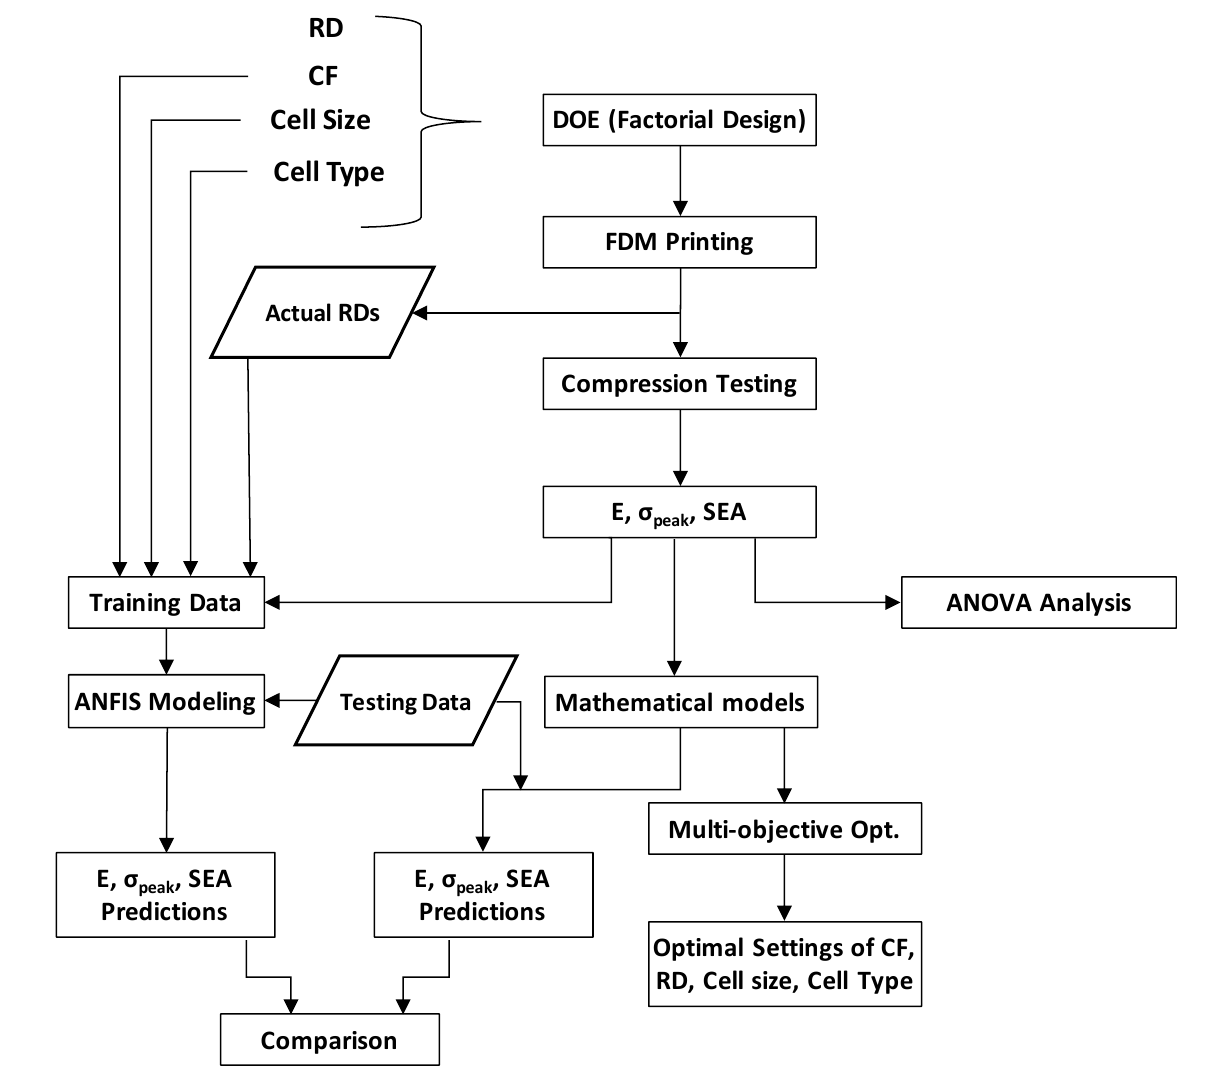
Figure 5. Methodology adopted in this study.